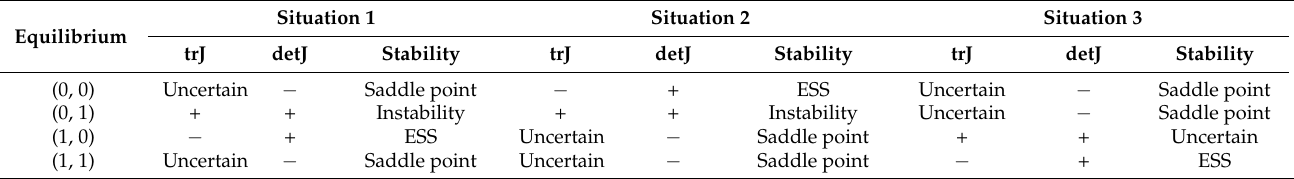
Table 3. Local stability of the equilibrium point (Situations 1, 2 and 3).